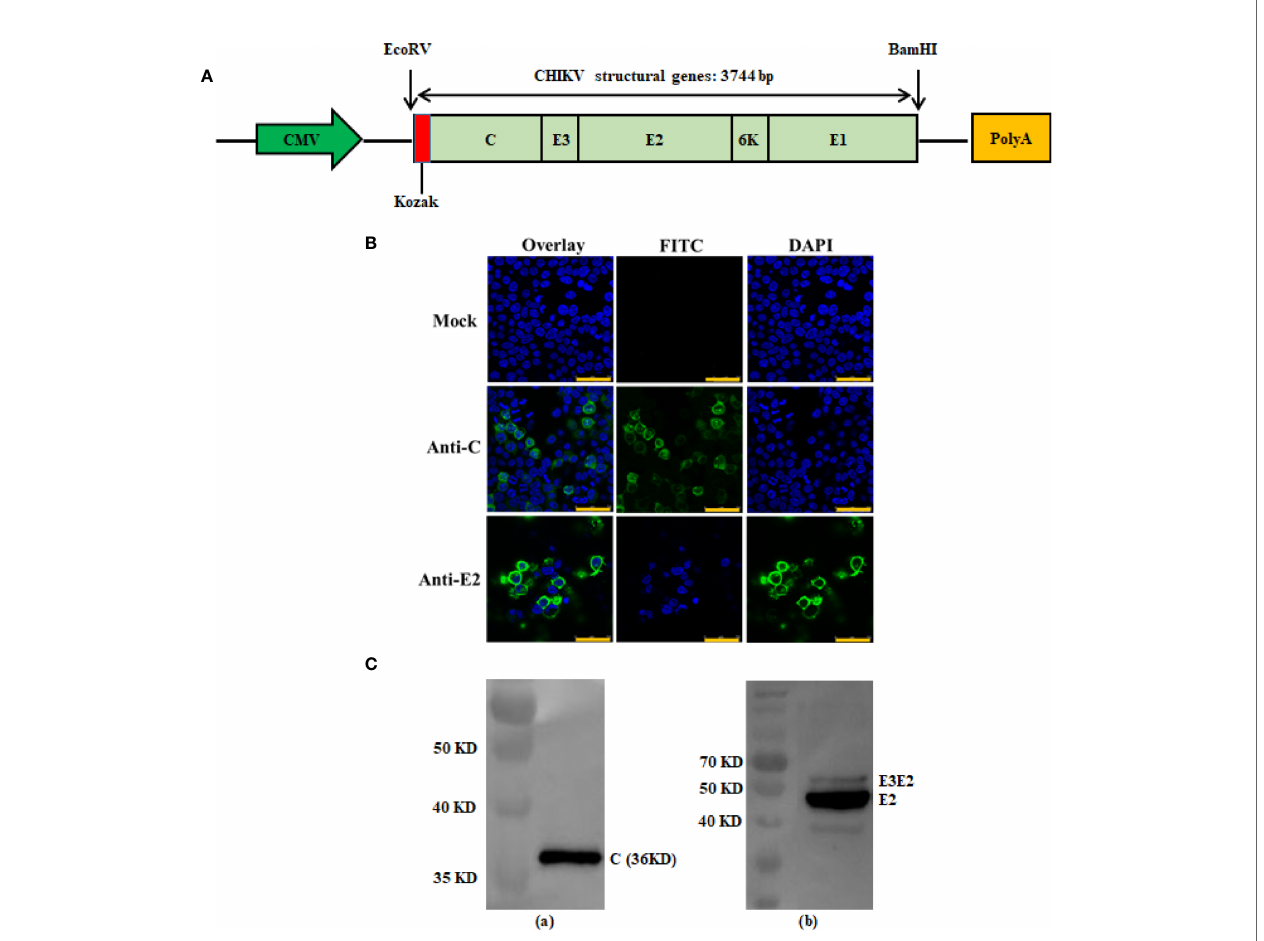
FIGURE 1 | Construction and antigen expression analysis of recombinant DNA-based CHIKV vaccine candidate. Schematic diagrams of the recombinant DNA- based vaccine encoding CHIKV structural genes. The fl anking enzyme sites used for cloning, Kozak expression element and CHIKV structural genes (C-E3-E2-6K- E1) are indicated and were cloned into the VRC-8301 vector (A) . Immuno fl uorescence staining images showing the 293T cells transiently transfected with the pVRC- CHIKV or VRC-8301 (mock) at 24 h post-transfection. The capsid and E2 protein (FITC) and cell nuclei (DAPI) were stained in green and blue, respectively. Scale bars, 50µm (B) . Expression of pVRC-CHIKV constructs was con fi rmed in vitro using CHIKV Capsid and E2 rabbit polyclonal antibodies for the Western blot of CHIKV Capsid (left) and E2 (right) proteins expressed in 293T cells by Western blotting (C)